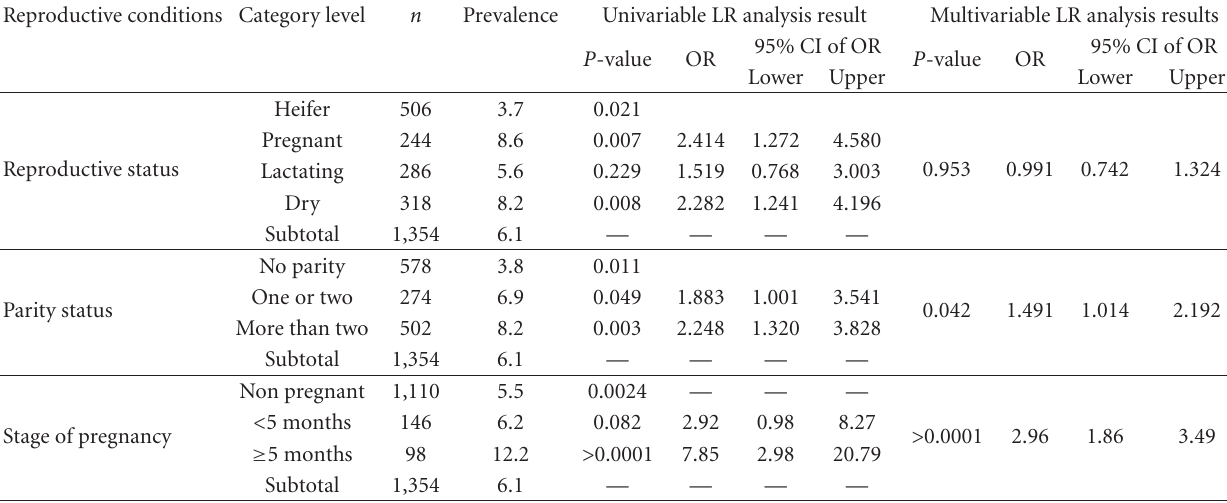
Table 2: Summary results of the univariable and multivariable logistic regression (LR) analyses of reproductive conditions with dependent Brucella seropositivity in female cattle in Western Tigray, North West Ethiopia. OR: odds ratio, CI: confidence interval, October 2007 to February 2008.